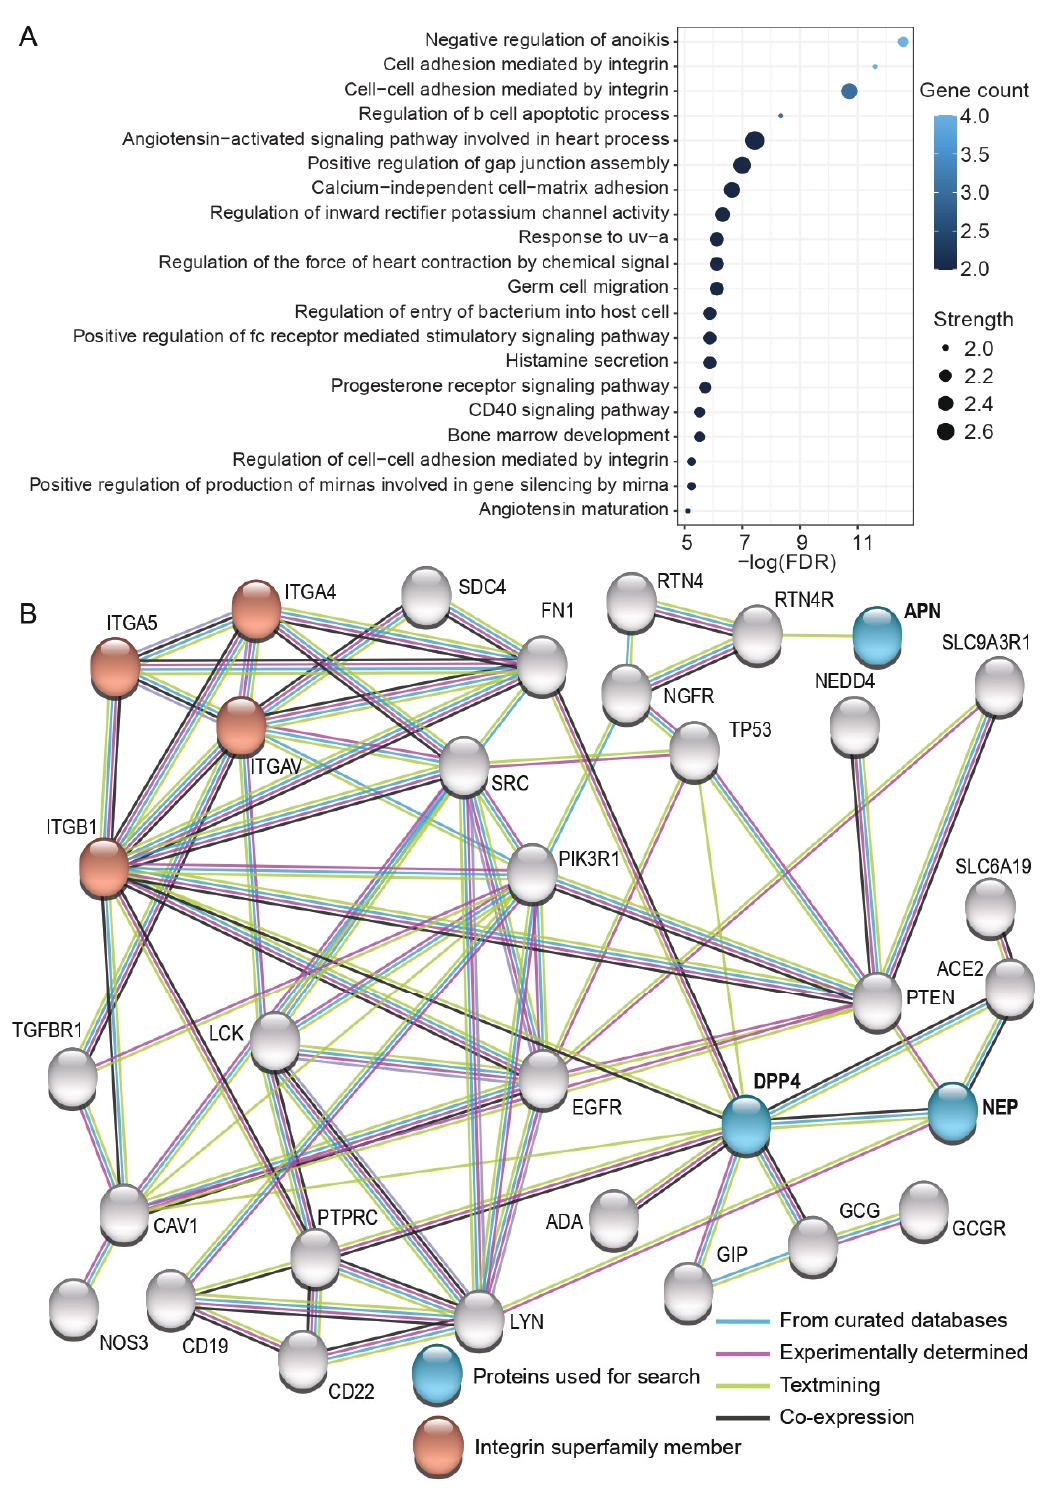
Figure 5. Functional enrichment ( A ) and network map ( B ) of the interactive proteome of DPP4, NEP, and APN in humans. Interactive proteins are based on the Search Tool for the Retrieval of Interacting Genes/Proteins (STRING) with high confidence interactions (see methods for details). Proteins inputted to the tool are indicated in blue and the proteins belonging to the integrin superfamily are marked in red. The source of interactions is indicated using colored lines: light blue stands for “curated databases”, purple refers to “experiments”, light green indicates “textmining”, and dark gray implies “co ‐ expression” of proteins. FDR = false discovery rate.